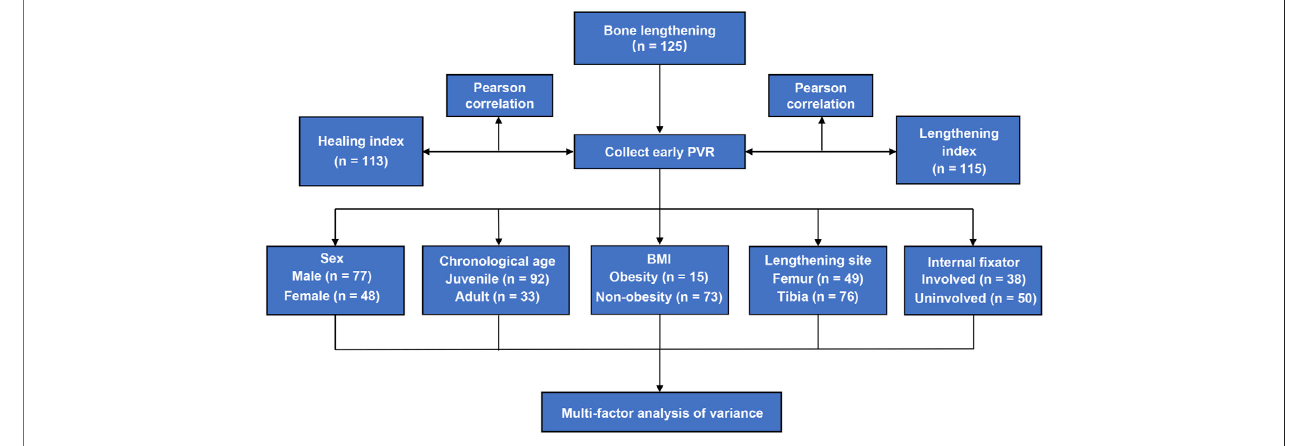
FIGURE 1 | Flowchart for the study design of this study.